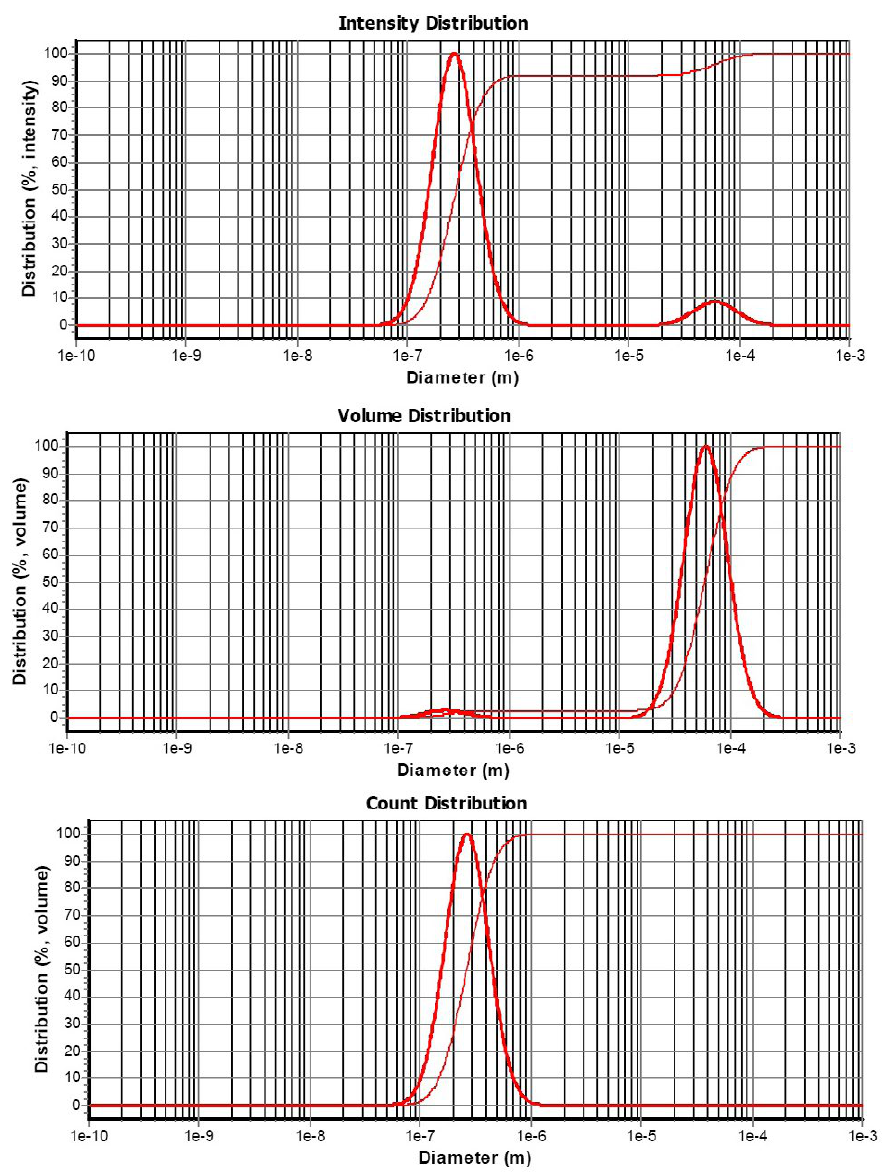
Fig. 4 . DLS of ZnO NPs at 90